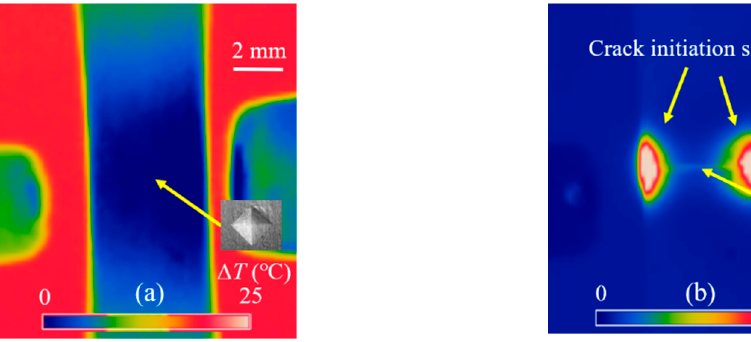
Figure 8. The temperature distribution of the specimen surface obtained by thermography in a 20% CW 316L specimen (indent depth is 80 μ m) tested at 400 MPa, which failed at 4.65 × 10 5 cycles. ( a ) Before fatigue test; ( b ) just before fatigue failure.